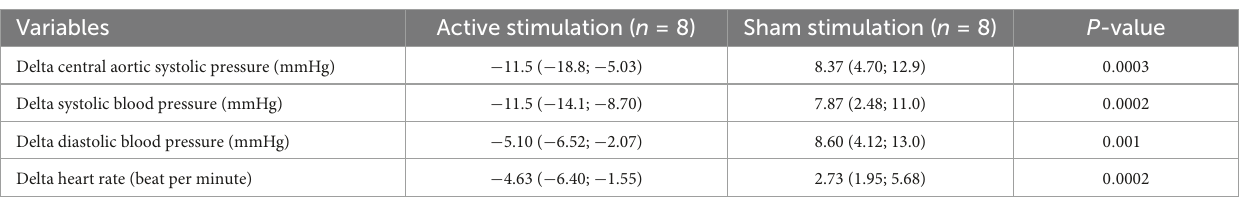
TABLE 3 Changes in CASP between active and sham stimulation